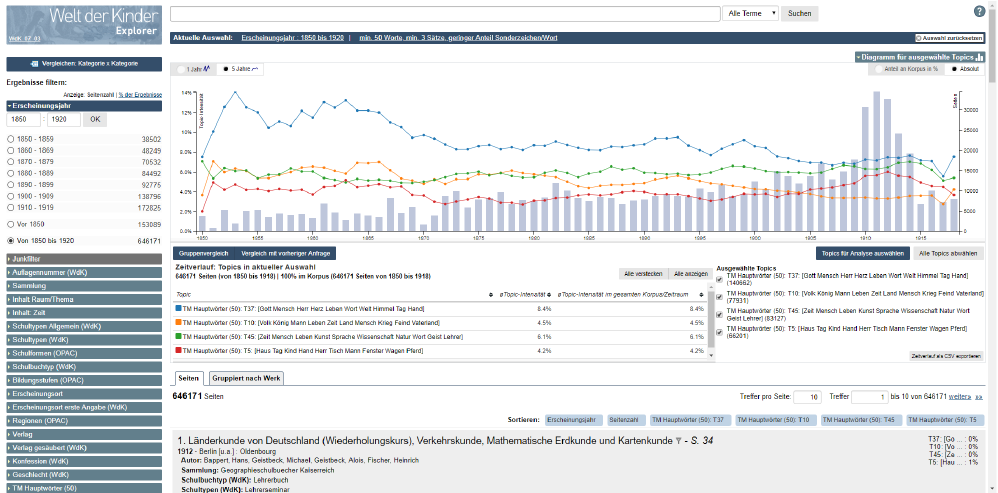
Figure 2. Screenshot of the Digital Humanities Tool “Children and their world” Explorer.